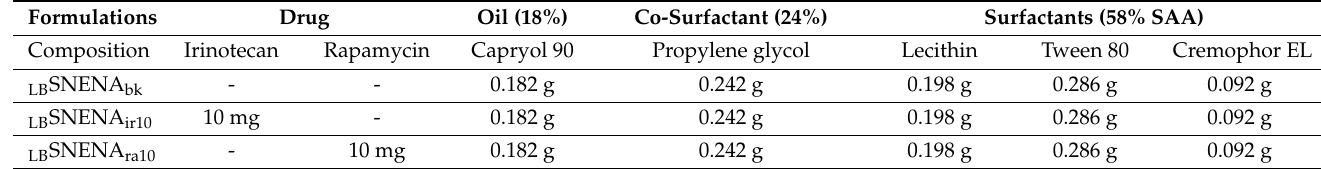
Table 1. Composition of 1 g LB SNENA bk , LB SNENA ir10 , and LB SNENA ra10